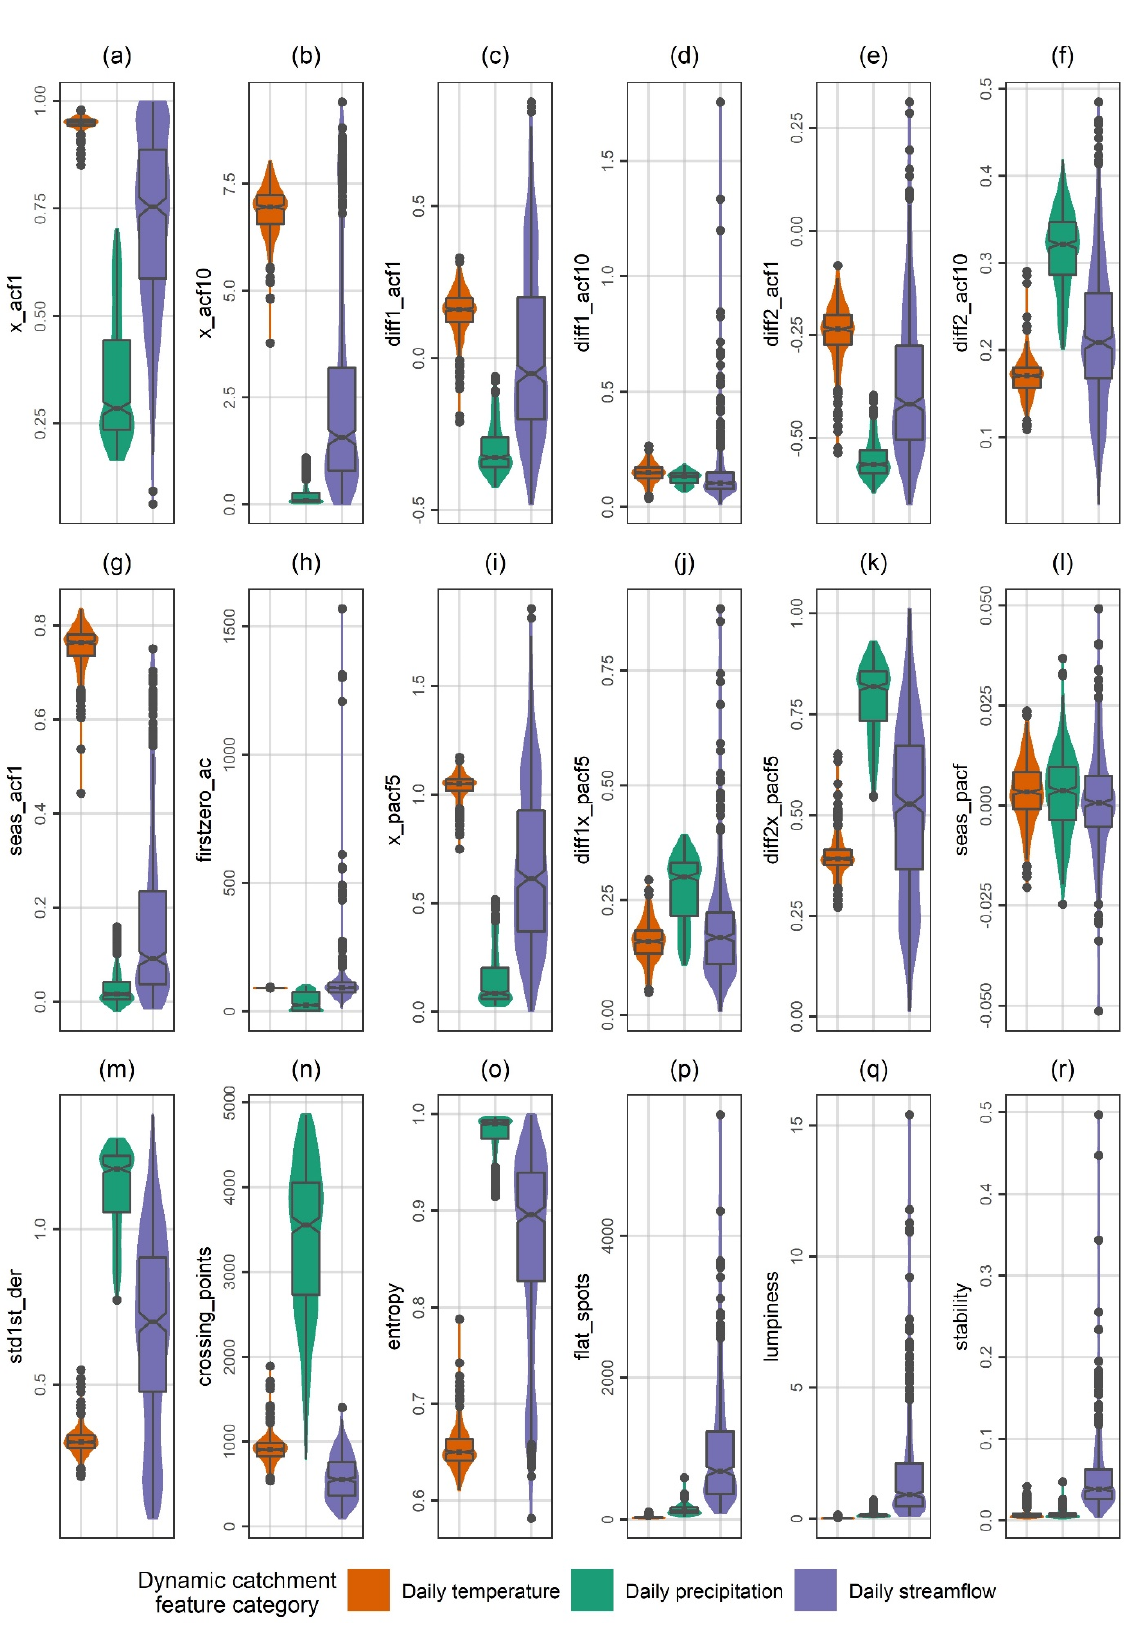
Figure B1. Summaries over the 511 investigated catchments of the estimated daily temperature, precipitation and streamflow features (part 1). For the explorations and predictions, these dynamic catchment features were merged with static catchment features. The displayed feature abbreviations are explained in Section 2.2.